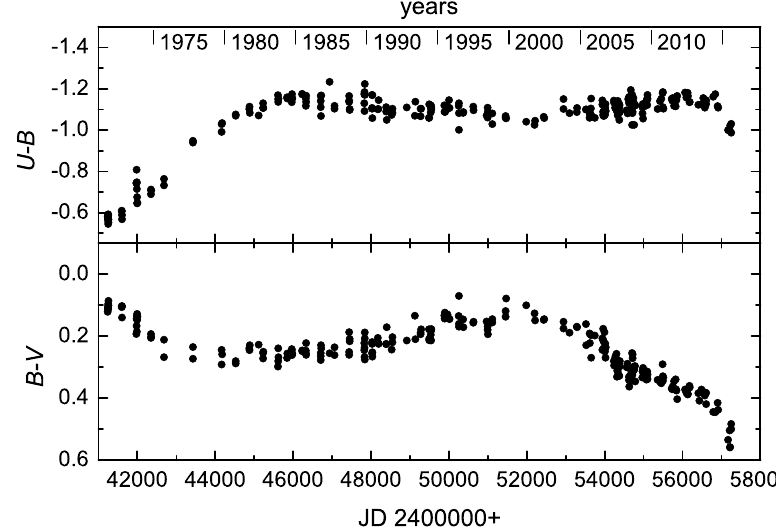
Fig. 2. The evolution of the B (cid:21) V and U (cid:21) B color indices of V1016 Cyg from 1971 to